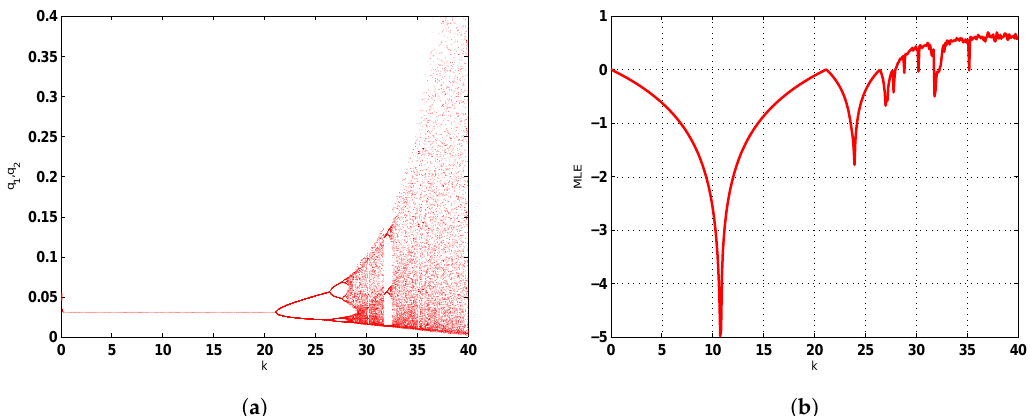
Figure 1. ( a ) bifurcation diagram of q 1, t and q 2, t when varying k ; ( b ) Lyapunov exponent with respect to k .